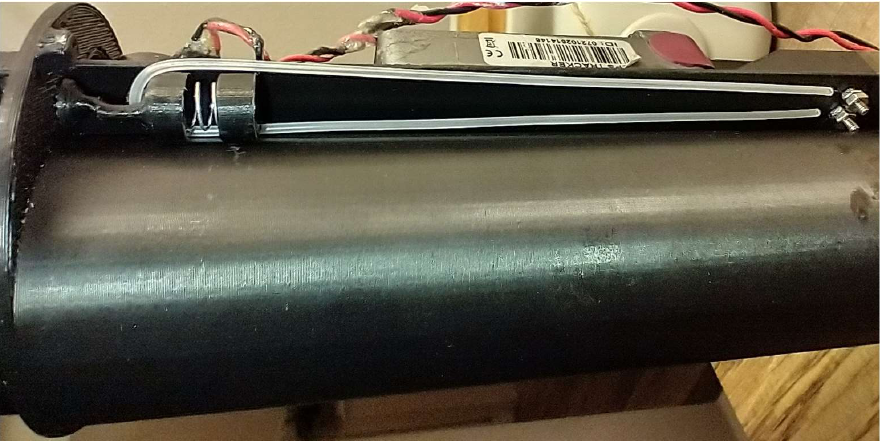
Figure 16. Shape memory alloy wire with silicone sheath. The mechanism for the stowed parawing hold-down and release is presented in Figure 17. The thin high-tensile strength lines hold the circular “cap” closed. When the pin (visible in the hole in the lug to the right of the capsule) is pulled, the loop is released, allowing the cap to open. The lug containing the pin that releases the payload from the balloon is visible to the left of the capsule.